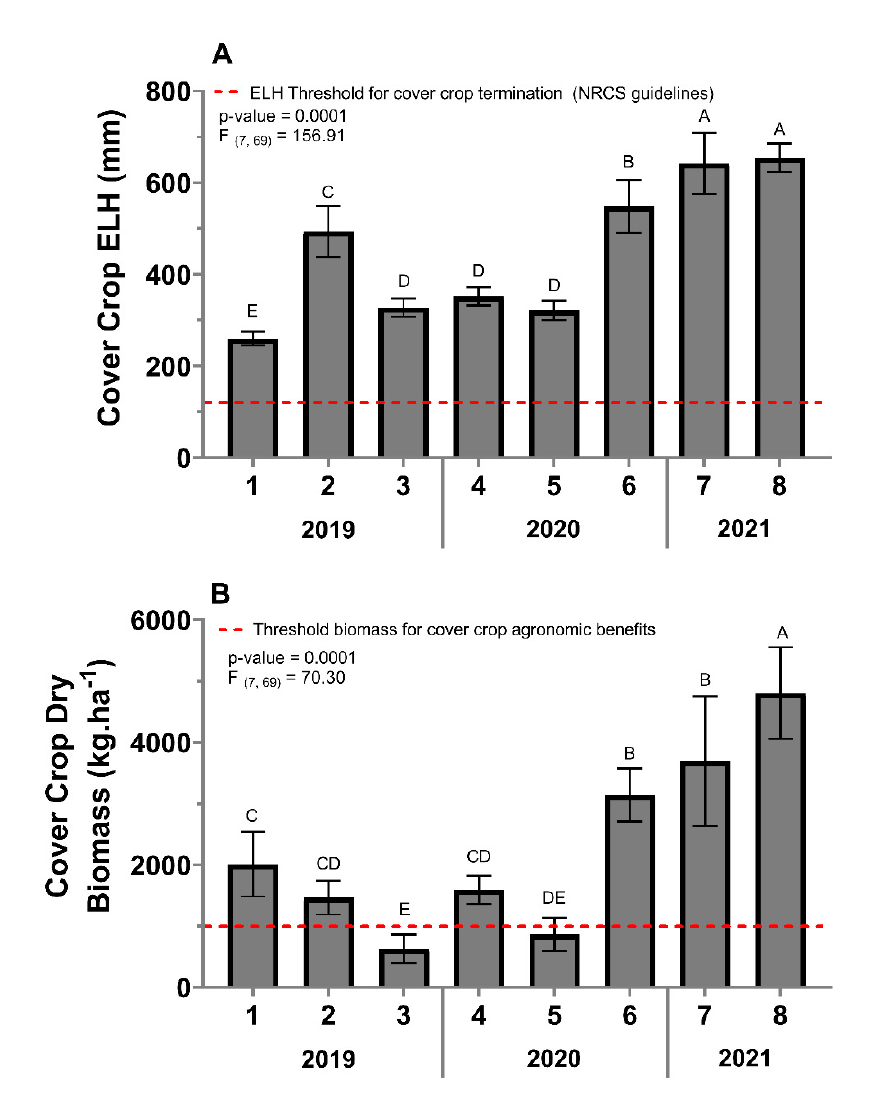
Figure 2. Cover crop extended leaf height (ELH) ( A ) and cover-crop biomass ( B ) per site taken at cover-crop termination. Error bars indicate the standard error of the means. The same letters represent no statistically significant difference at p < 0.05.